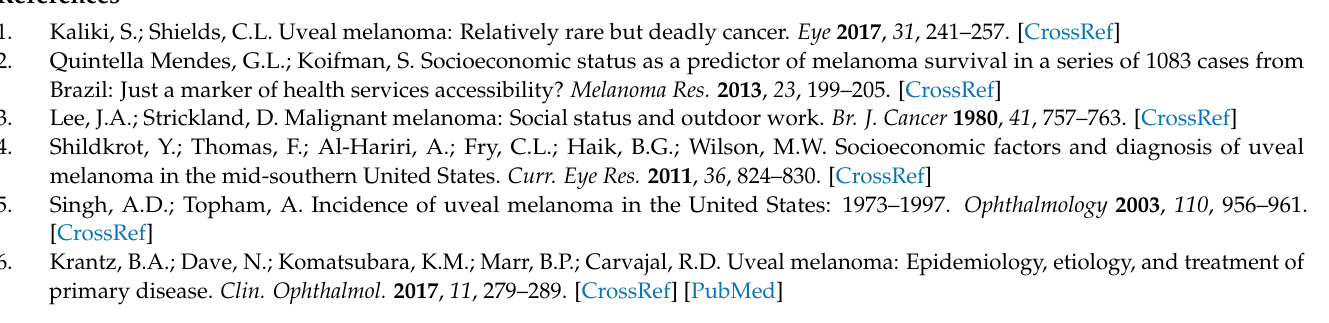
women; Table S2: Network analysis of the significant protein-coding genes listed in Supplemental Table